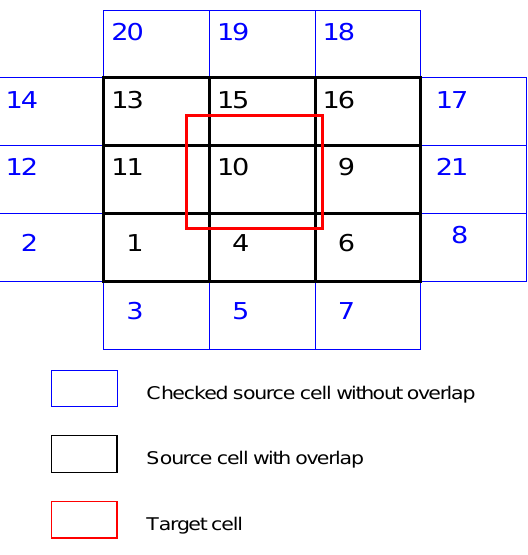
Fig. 4. Search of source cells for conservative remapping. Num- bers indicate the sequence in which the source cell are investigated